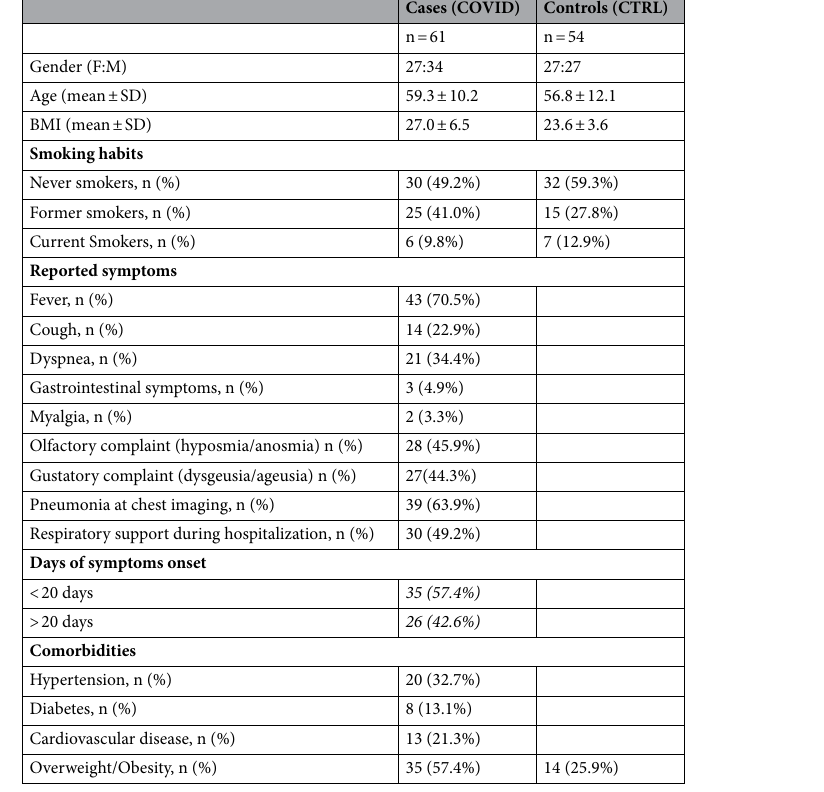
Table 1. General and clinical features of cases and